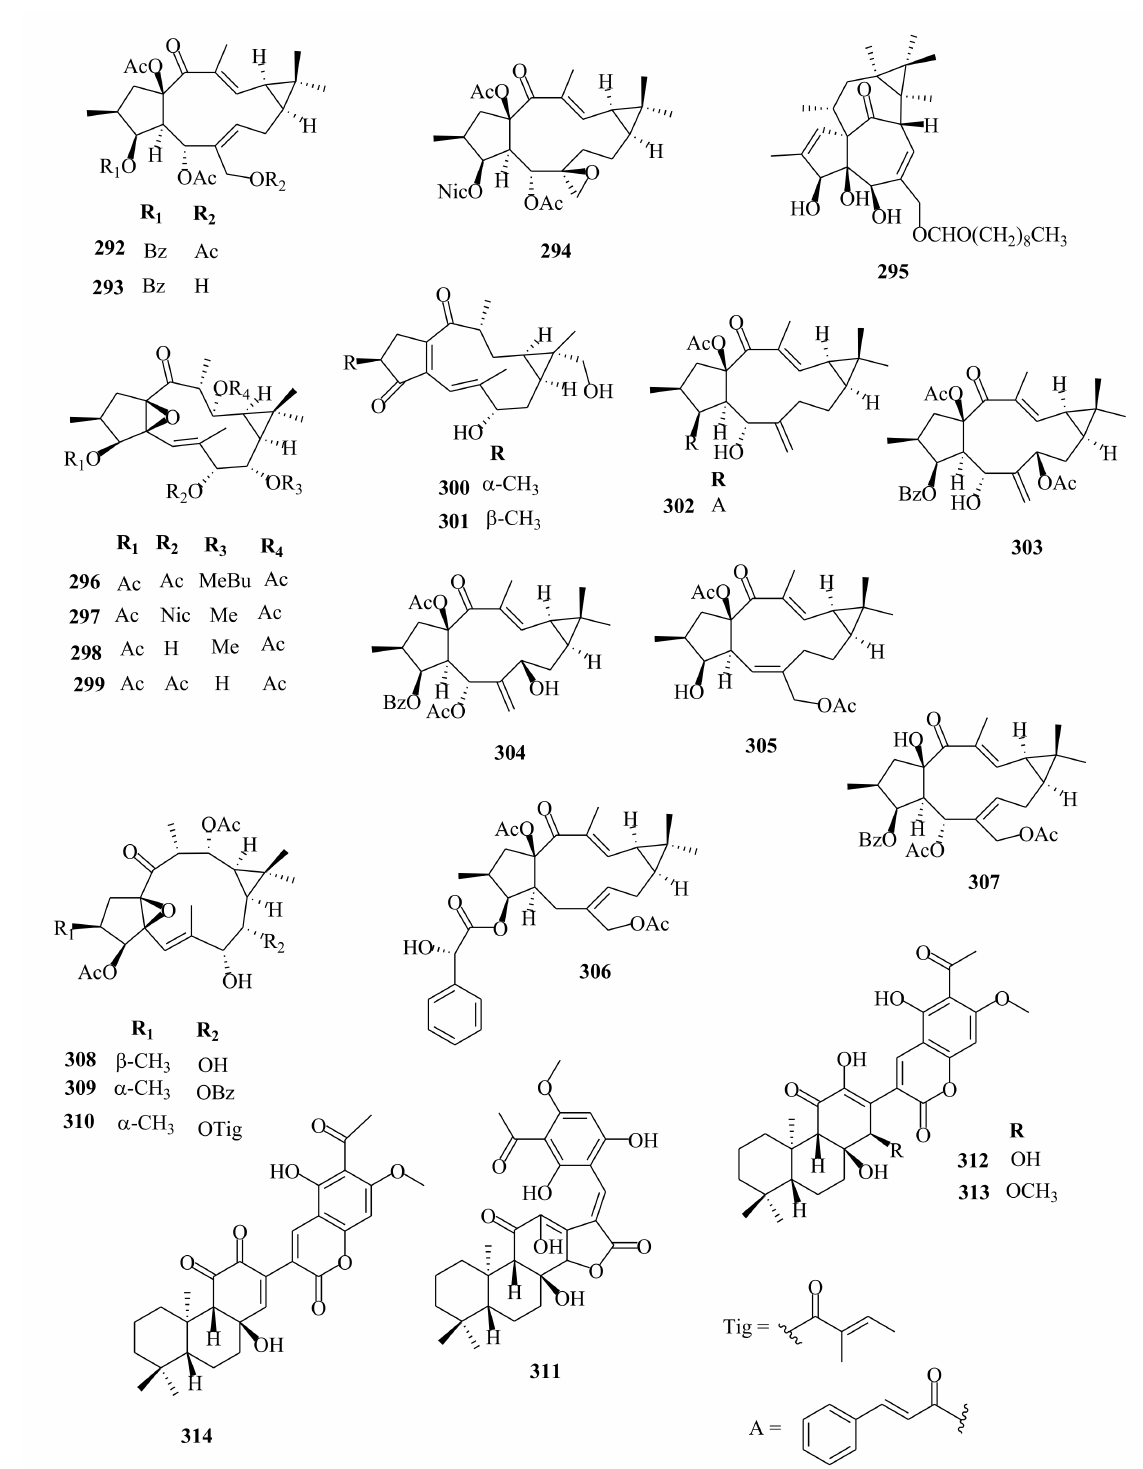
Figure 12. Chemical structures of Euphorbia lathyrane and meroterpenoid